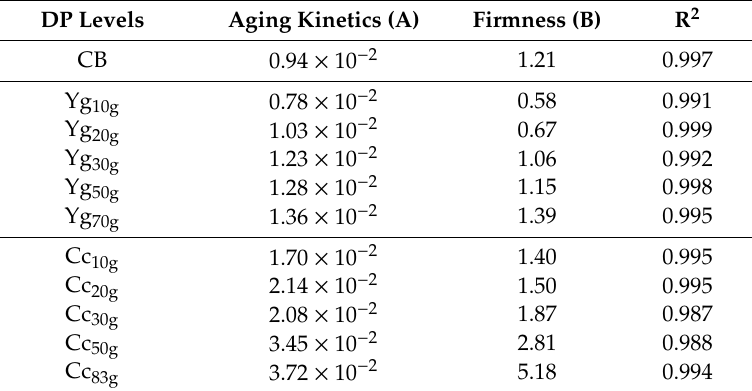
Table 2. Parameters of linear relationship: bread aging kinetics (A) and firmness (B) obtained for control bread (CB—0 g / 100 g) and for the di ff erent levels of yoghurt (Yg) and curd cheese (Cc)